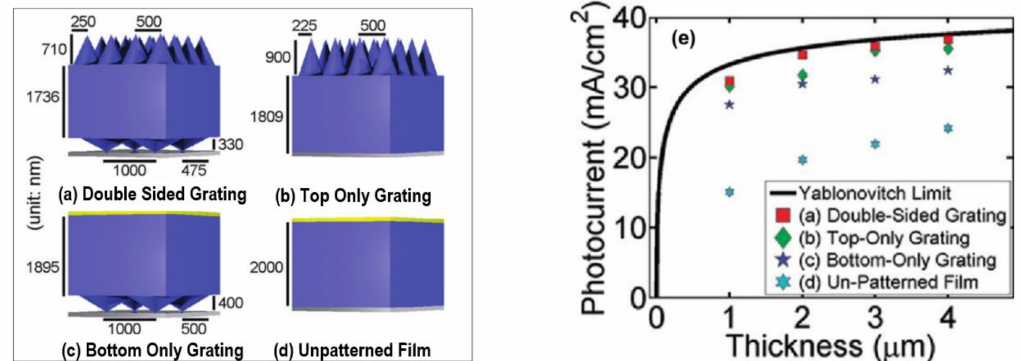
Figure 13. Three-dimensional silicon thin-film structures in air. From ( a ) to ( d ), blue represents silicon, gray represents a perfect electric conductor (PEC), and yellow represents nonabsorbing silicon nitride. The nanocones were made of silicon, as were the uniform layers, and they were placed in a two-dimensional square lattice either on the front or on the back surface of the film. ( a ) The optimized double-sided nanostructure. ( b ) The optimized top-only nanostructure. ( c ) The optimized bottom-only nanostructure with a thin layer of nonabsorbing silicon nitride on top. ( d ) The flat film with a thin layer of nonabsorbing silicon nitride on top [178]. ( e ) Photocurrents generated by structures as a function of their equivalent thicknesses. (Reprinted with permission from [178], 2012, American Chemical